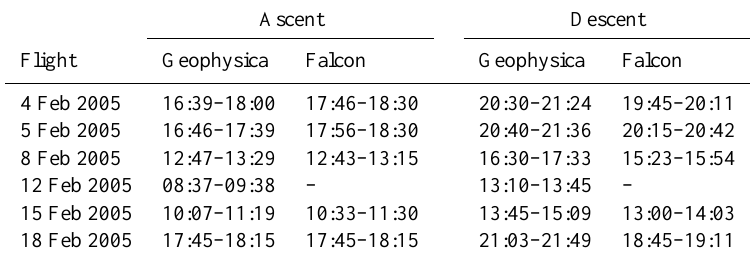
Table A1. Time of ascent and descent measurements for the Geophysica and Falcon research aircraft during the TROCCINOX campaign (given in local